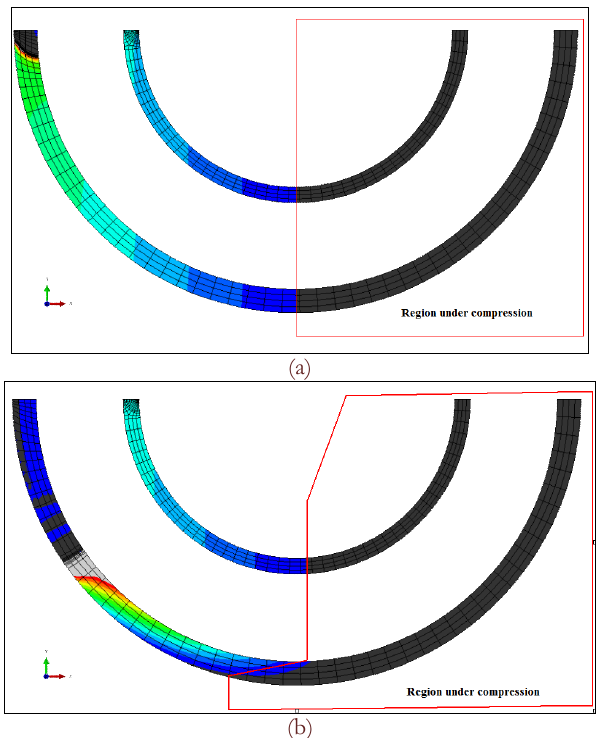
Figure 22: Crack configurations from FE analysis: (a) initial crack configuration; (b) extended crack